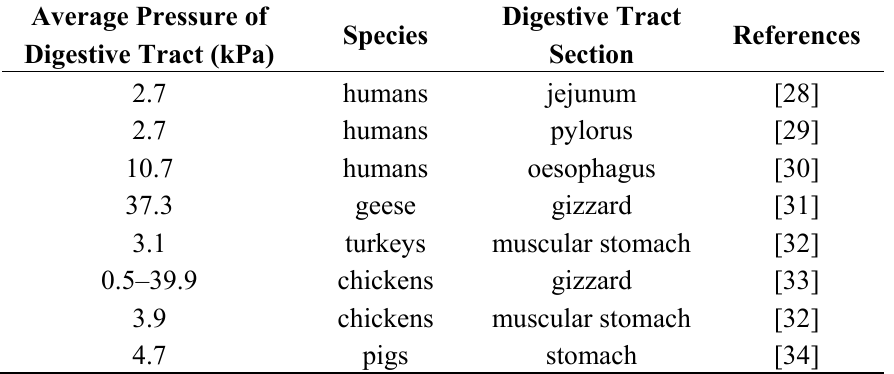
Table 2. Pressure values exerted in different parts of the digestive tract of several livestock species. The optimal pressure for the clay-mediated transformation of bacteria by plasmid DNA is reported to be 3.9 kPa [22]. The numbers shown have been converted to the international system unit for